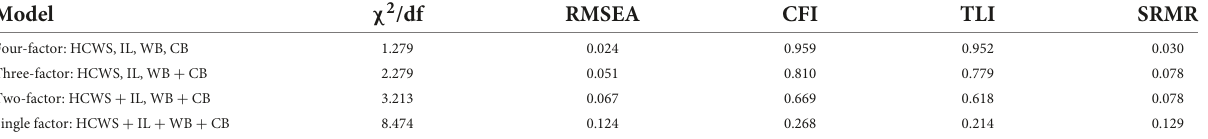
TABLE 2 Results of multilevel confirmatory factor analysis.